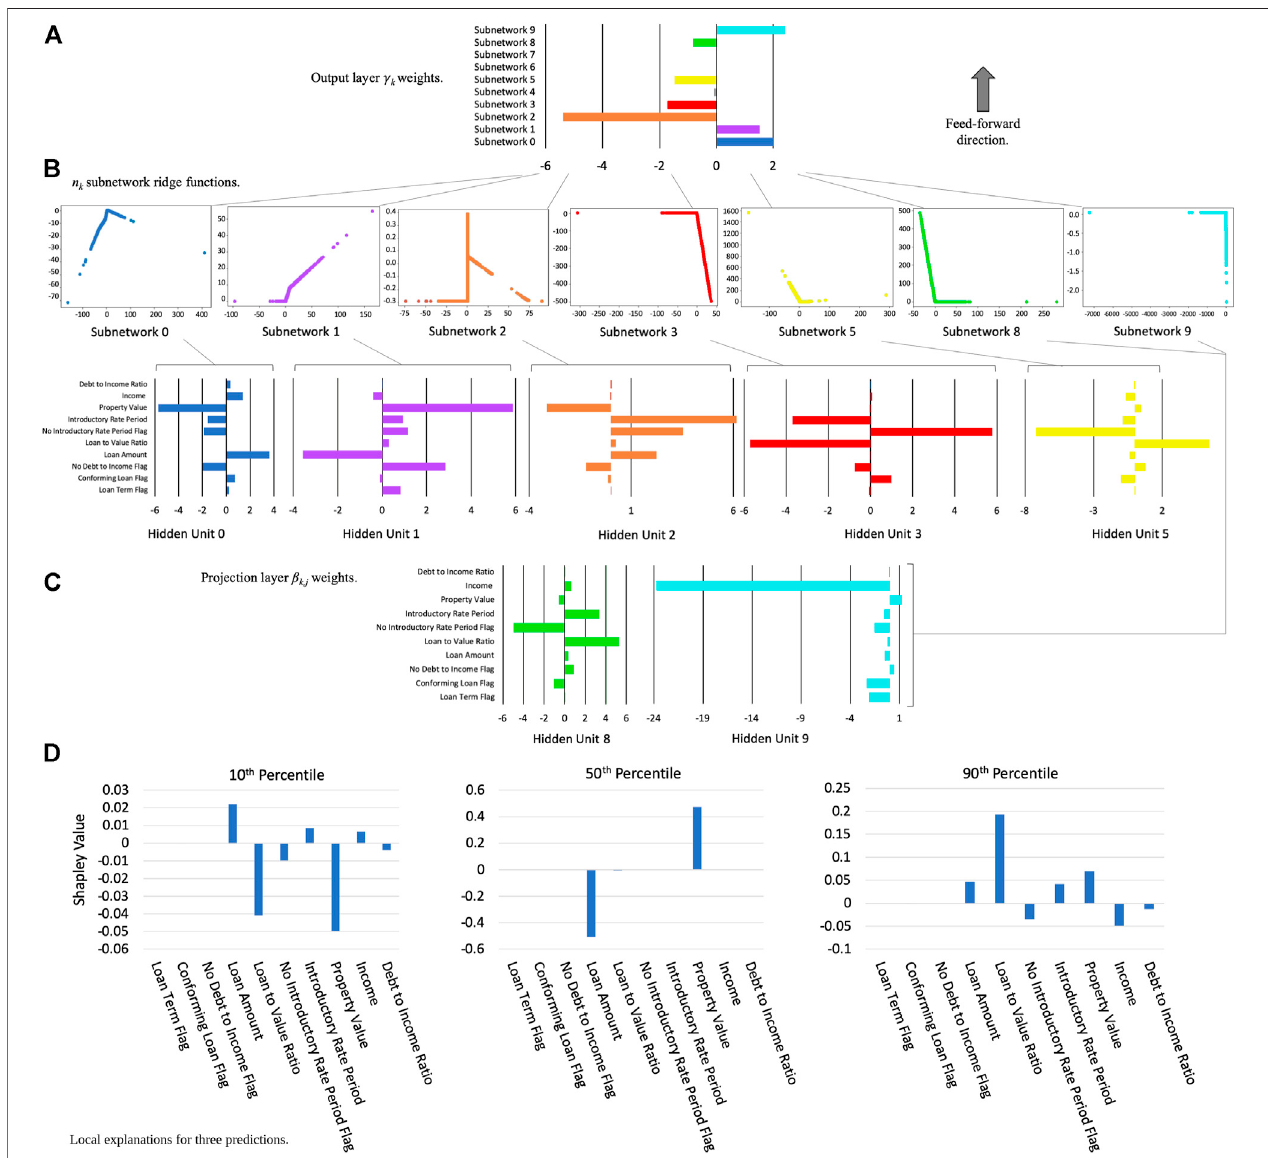
FIGURE 2 | An XNN trained to predict high-priced loans from publicly available mortgage data and local Shapley feature contributions for three speci fi c customer predictions (Vaughan et al., 2018): (A) . XNN output layer — global weighting of n k subnetworks for XNN output; (B) . Internal subnetworks — n k subnetworks associated with a speci fi c weighting in projection layer β k,j weights; (C) . Projection layer — input layer weights that project data into the next layer of the XNN; and (D) . Shapley value localfeaturecontributionsforcustomersatthe10th,50th,and90thpercentilesofmodeloutput,calculatedwiththeDeepSHAPmethod(LundbergandLee,2017; Gill et al.,